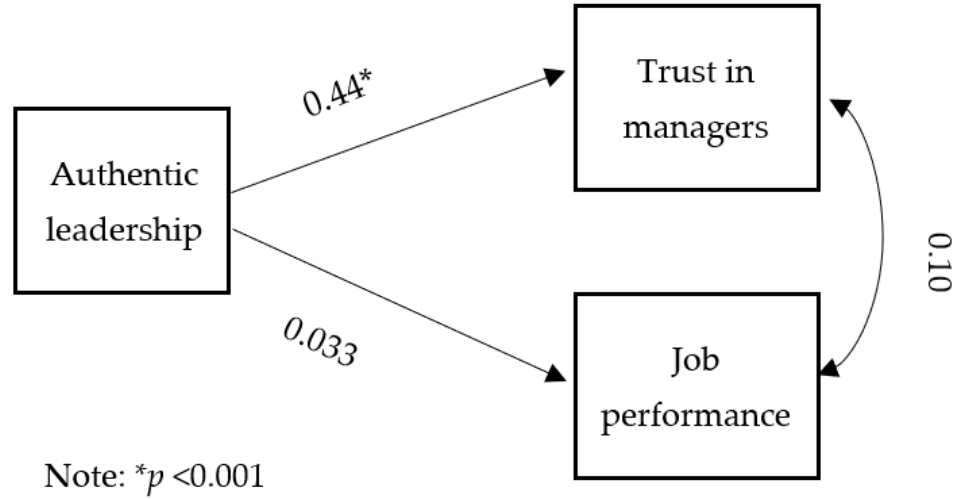
Figure 2. Results of hypothesized model.